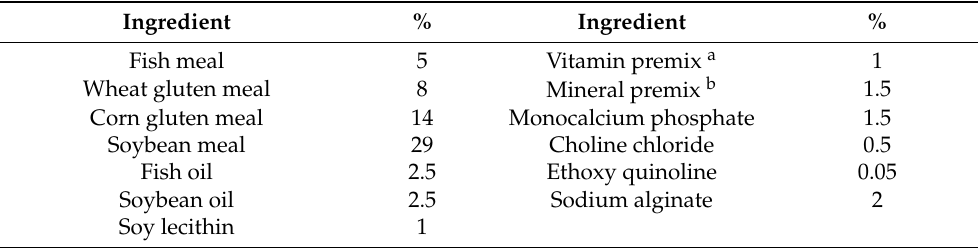
Table 1. Formulation and proximate composition of the basal diet (% dry